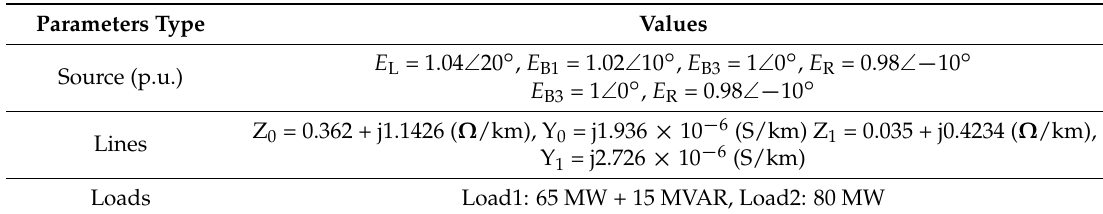
Table 2. Parameters of simulated lines.